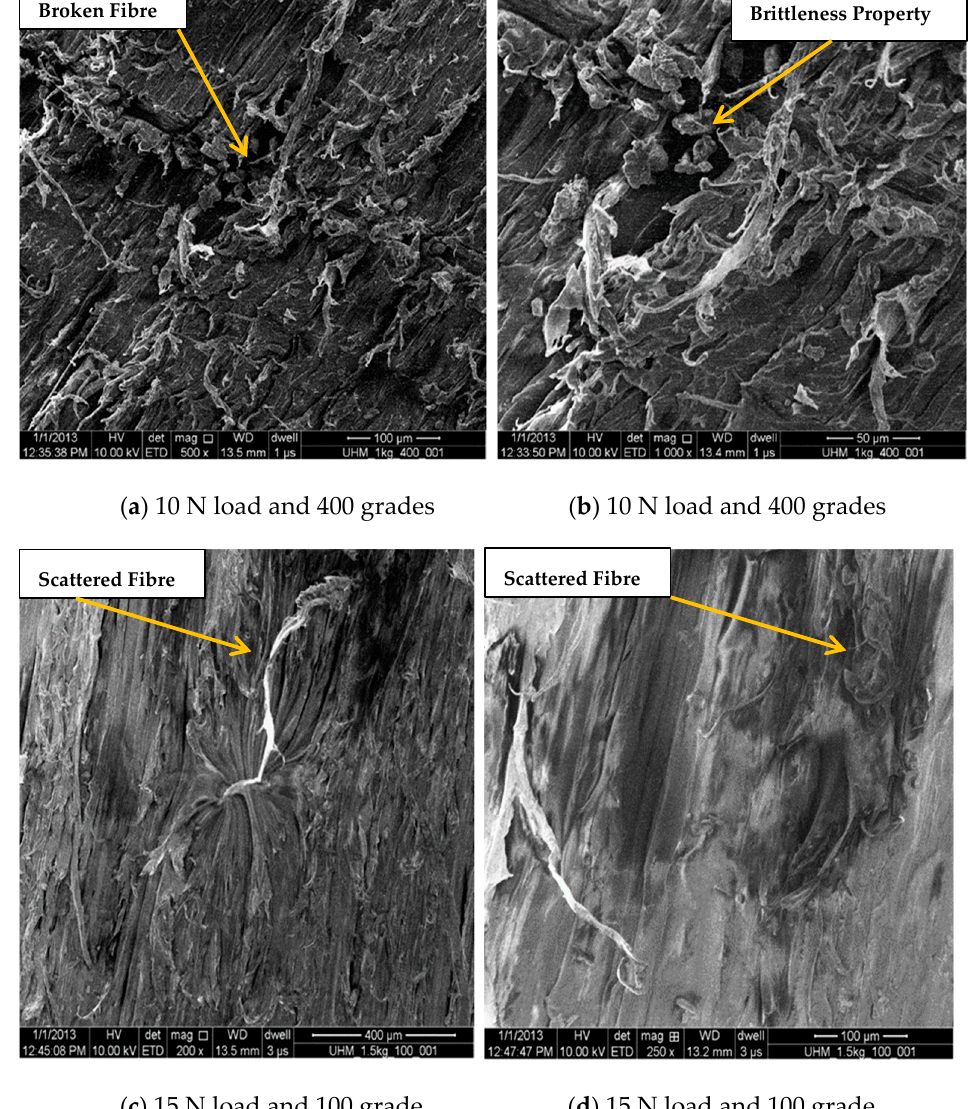
Figure 7. SEM analysis of UHMWPE at different load and grade conditions.